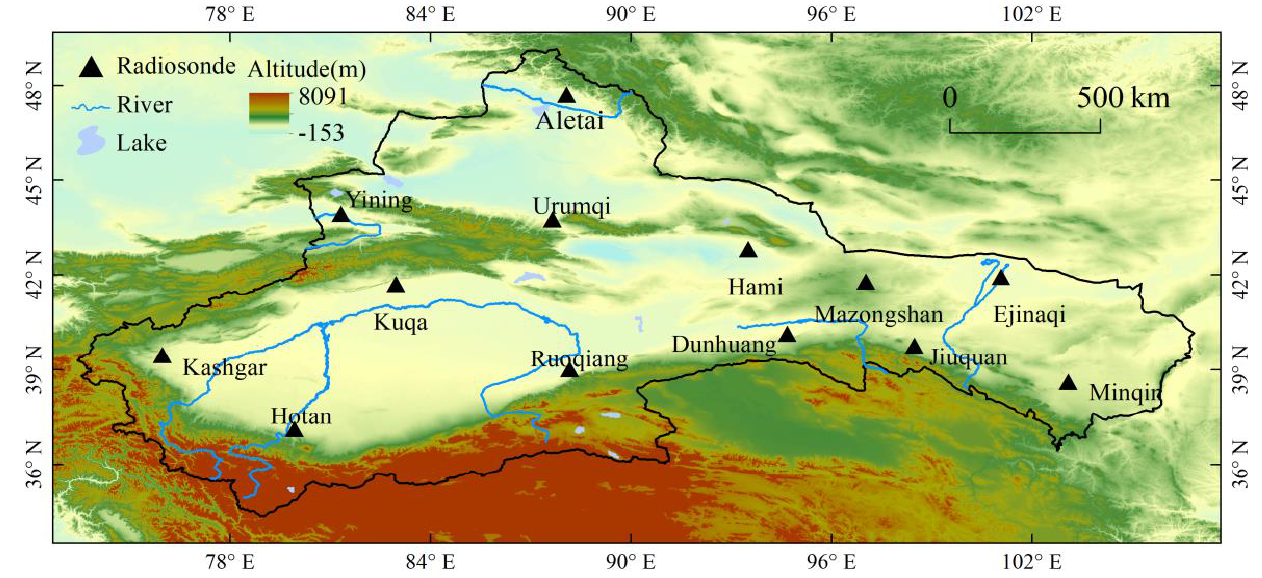
Figure 1. Location of the study region and distribution of radiosonde stations.